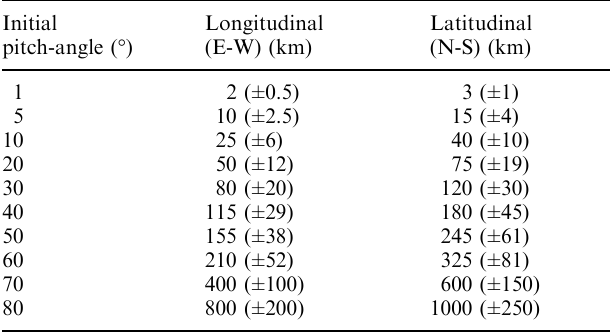
E-W is geomagnetic east-west direction, N-S is geomagnetic north- south direction